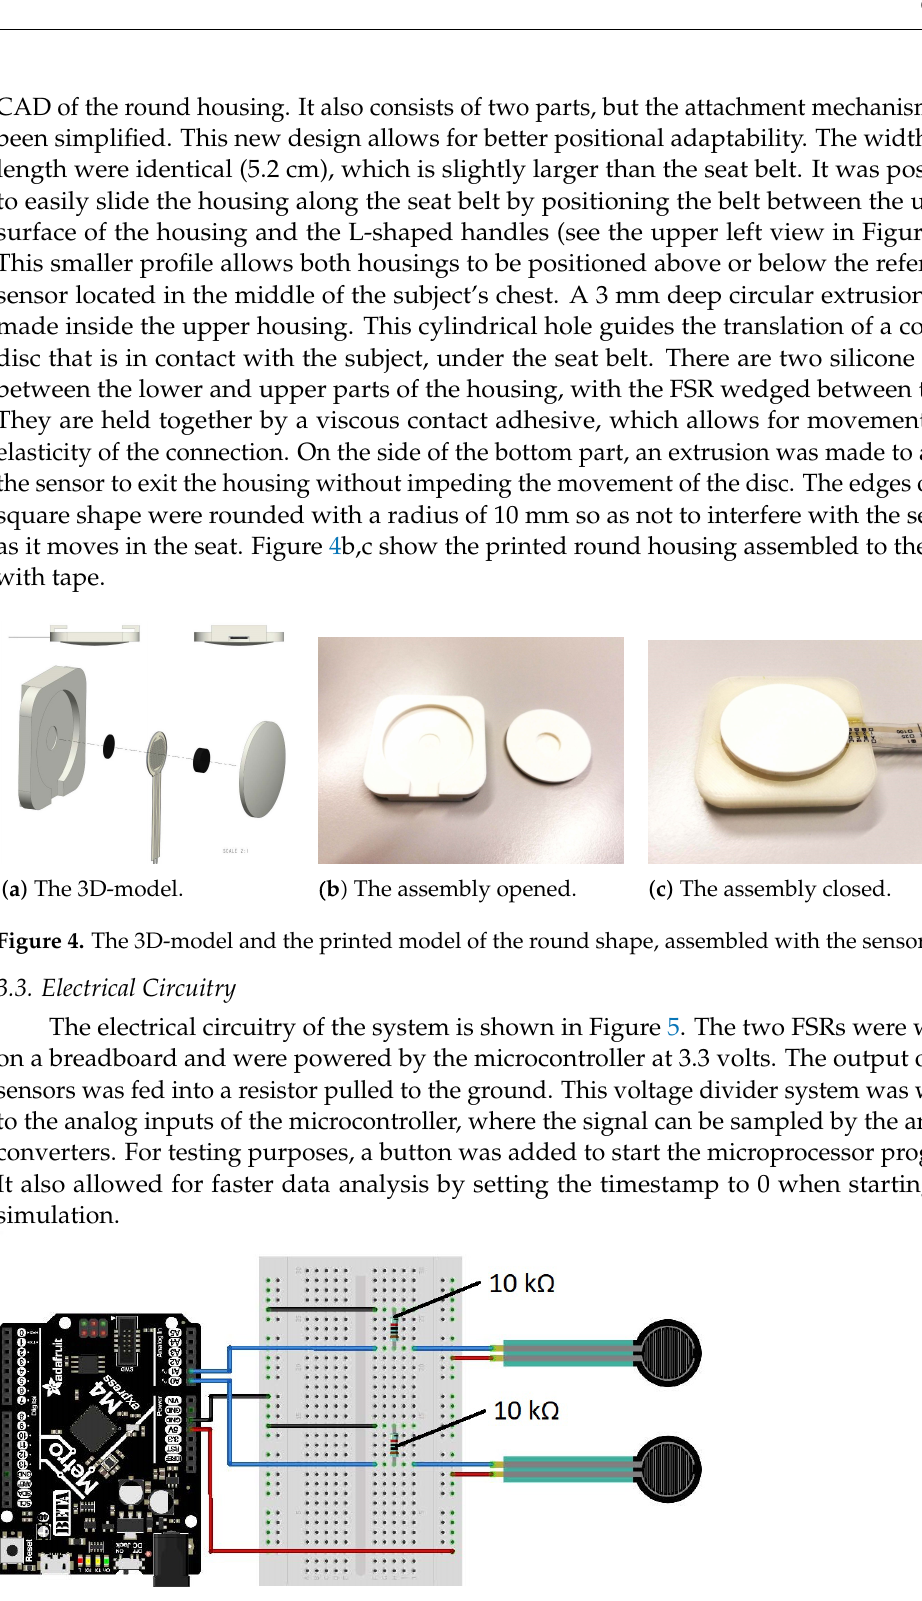
Figure 5. Sketch of the electrical wiring of the